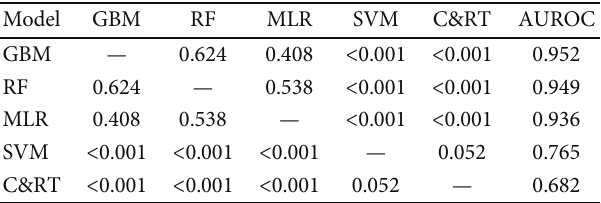
Table 5: The details of pairwise comparisons of the P